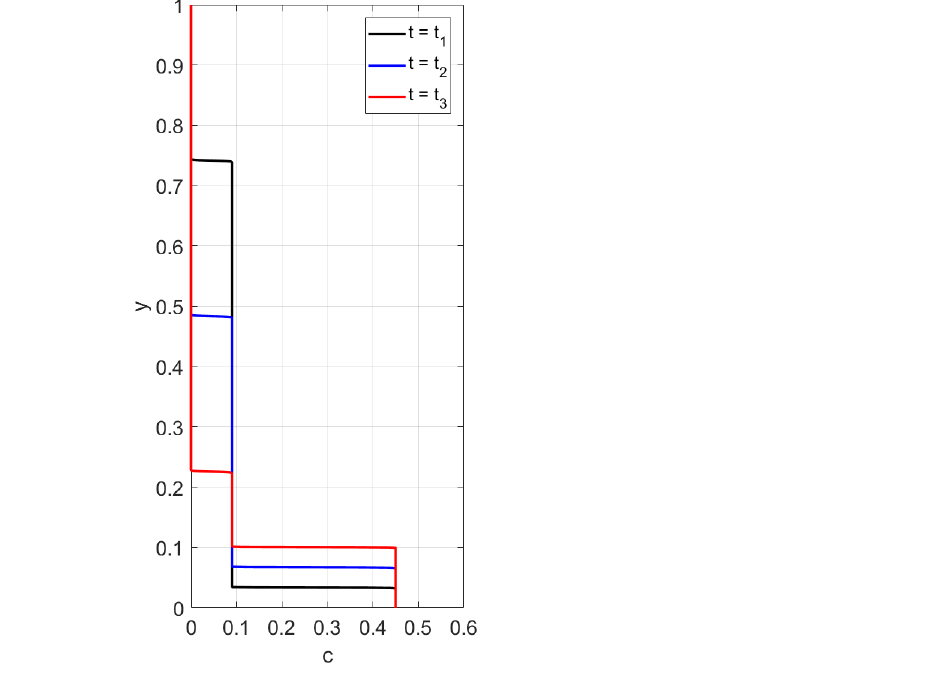
Figure 14. Calculated profiles of the concentration wave at different time instances for the flux F rz ( c ) with m = 4.65. The initial and boundary data are c 0 = 0.09, c bot = 0.45, c top = 0. The rising discontinuity wave is not followed by a centered rarefaction